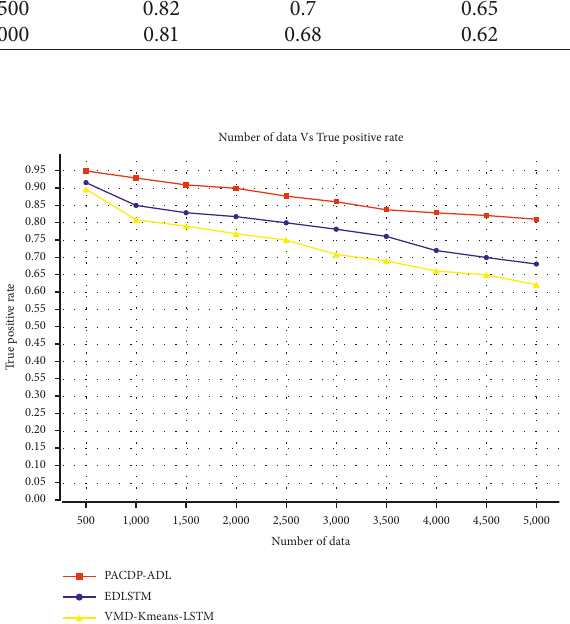
Figure 5: Graphical representation of wind power prediction time.